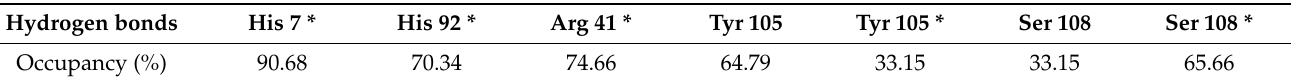
Table 1. The occupancy of the hydrogen bond interactions between the residues in the active site of kp HIUH and the substrate 5-HIU in complex 2 . Residue names followed by an asterisk (*) are from the adjoining chain. Hydrogen